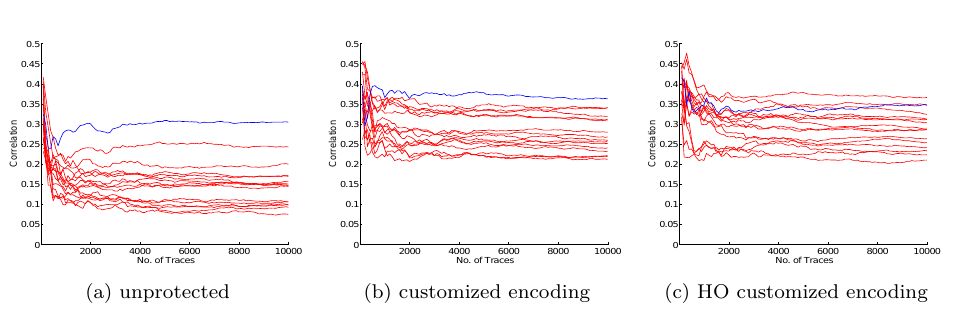
Figure 15: Basic CPA with HW model assuming HO leakage, blue line indicating correct key hypothesis and red lines indicating the wrong key hypotheses